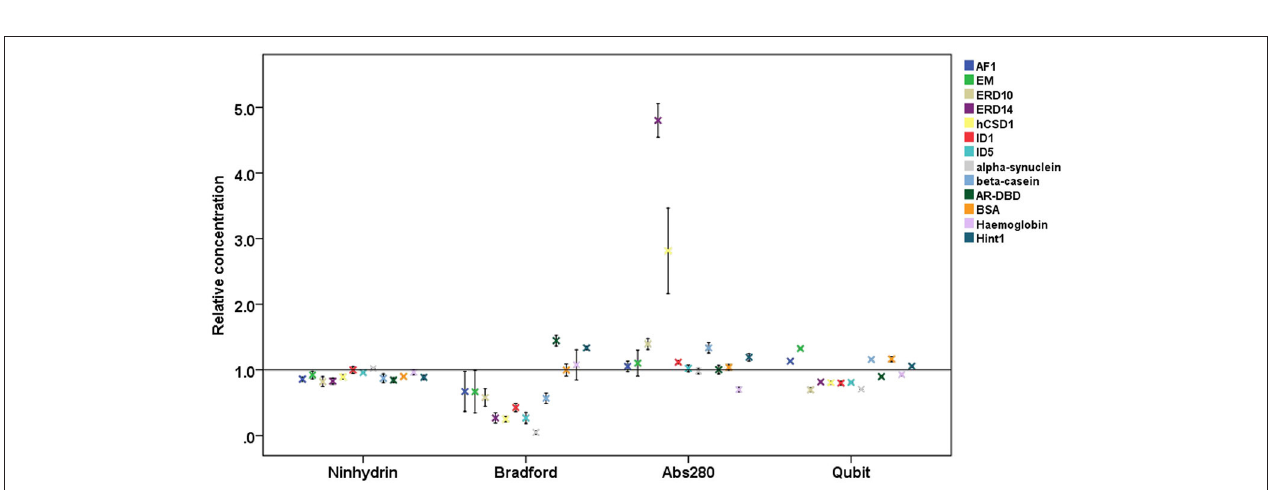
FIGURE 2 | Relative protein concentrations measured by different assays. Results of the concentration measurements by four different methods of 13 proteins (4 globular proteins and 9 IDPs, cf. Table 1 ), normalized to the absolute concentration measured by elemental analysis. Plots show mean ± SD for the four different quantification